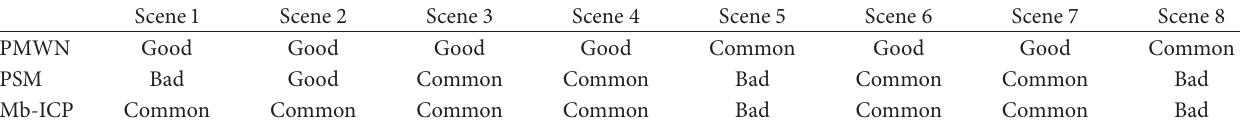
Table 3: Performance of the three algorithms in the eight scenes.